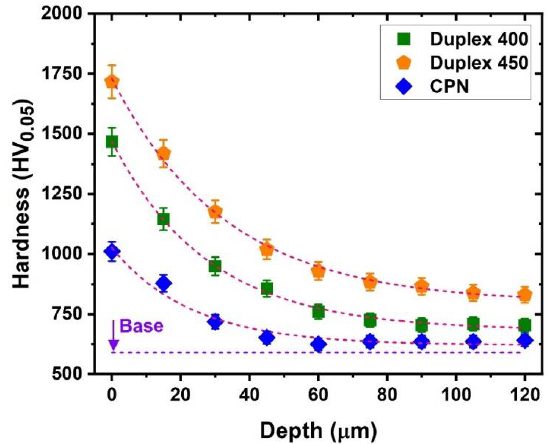
Figure 1. Hardness profile of conventional plasma-nitrided (CPN) and duplex-treated samples with substrate temperature for TiN deposition at 400 °C and 450 °C.